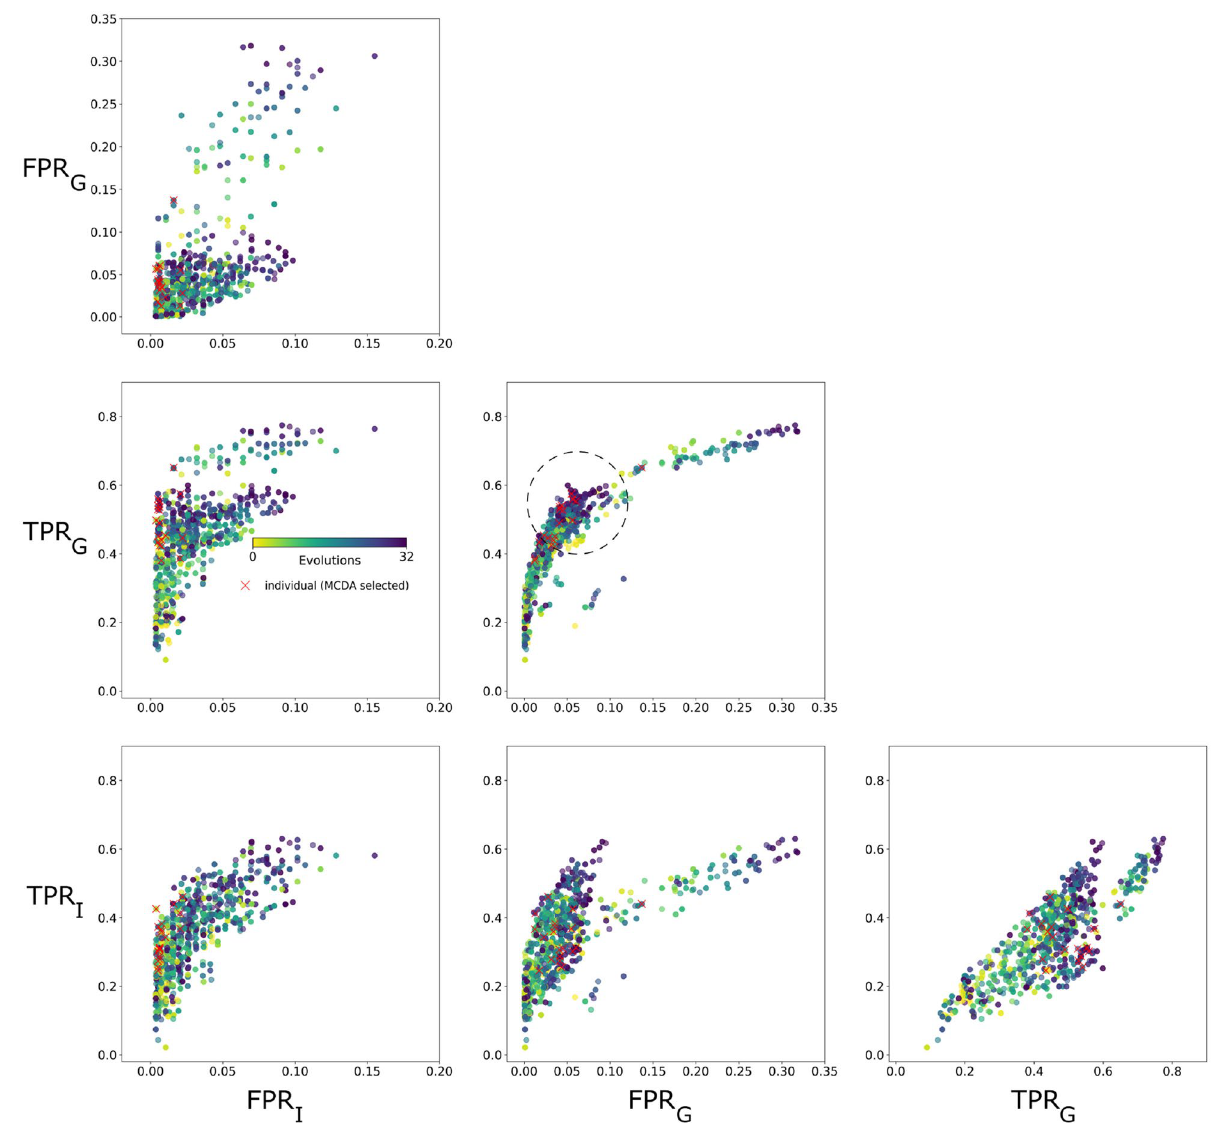
Figure 2. Objective function optimization for iFOD2. Pair-wise visualization of the optimization of four objective functions: TPR G and FPR G from the comparison between connectomes of 20 × 500 , and TPR I and FPR I from the comparison between individual connectomes of 1 × 500 . Our framework drives objectives toward the Pareto-front in the upper-left direction for the competing TP versus FP objectives. FPR G versus TPR G exposes a peak of optimal solutions (dotted circle). FPR I versus FPR G evinces the capability of our framework for controlling FP growth, maintaining values close to 0, at the bottom-left region. Best solutions, detected by MCDA, are shown as red x